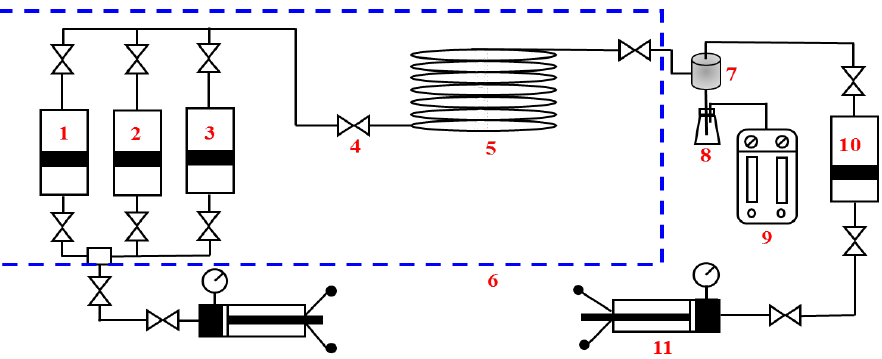
6 of 20 Figure 3. Flow chart of PVT behavior phase experiment flow: 1. High-pressure displacement pump, 2. PVT cell, 3. Constant temperature air bath, 4. Valve, 5. Gas – liquid Separation bottle, 6. Gas indi- cator bottle, 7. Gasometer. 2.3.2. Miscible Characteristics Experiment The detailed steps of slim-tube experiment for CO 2 injection and CO 2 – water co-injec- tion on the near-critical volatile oil were referred to the petroleum industry standard “ SY/T 6573 2016 Minimum miscible-phase pressure experimental determination method — slim-tube method ” [35]. The experimental flow is shown in Figure 4. (1) Slim-tube experiment for CO 2 injection on near-critical volatile oil consisted of the